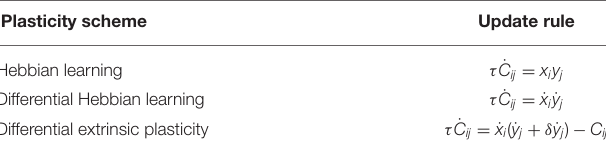
TABLE 1 | Different plasticity schemes. Plasticity scheme